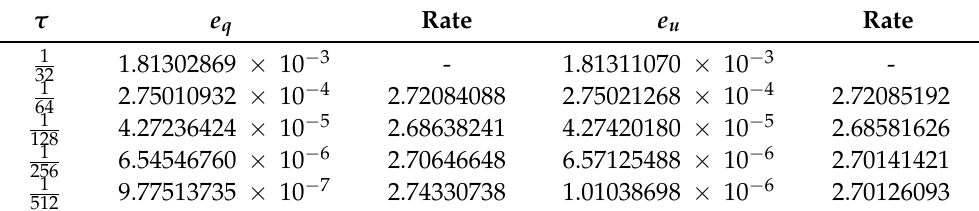
Table 4. Error e q and e u for the time convergence rates with α =